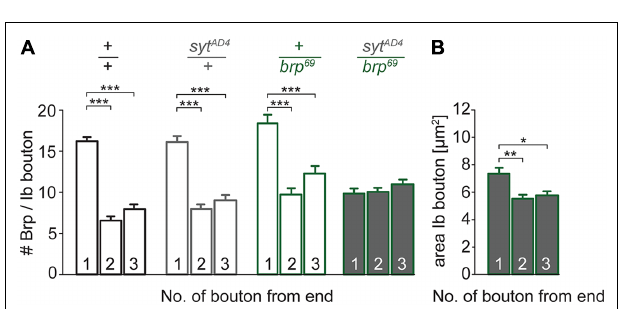
FIGURE 7 | Genetic interaction between brp and syt . (A) Summary bar graphs for the number of Brp puncta per terminal three type Ib boutons of wt ( + / + , black), heterozygous syt AD4 ( syt AD4 / + , gray), heterozygous brp 69 ( + / brp 69 , green) and trans-heterozygous syt AD4 /brp 69 larvae (gray with green edge). (B) Summary bar graph for the area of the three terminal type Ib boutons in syt AD4 /brp 69